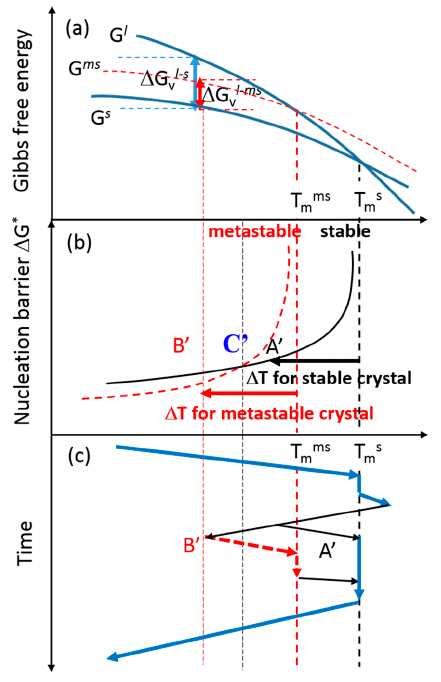
Figure 1. Schematic figures for Gibbs free energy of liquid, metastable and stable crystal phases ( a ), nucleation barrier ( b ), and melting and crystallization path ( c ) depending on undercooling in (b).